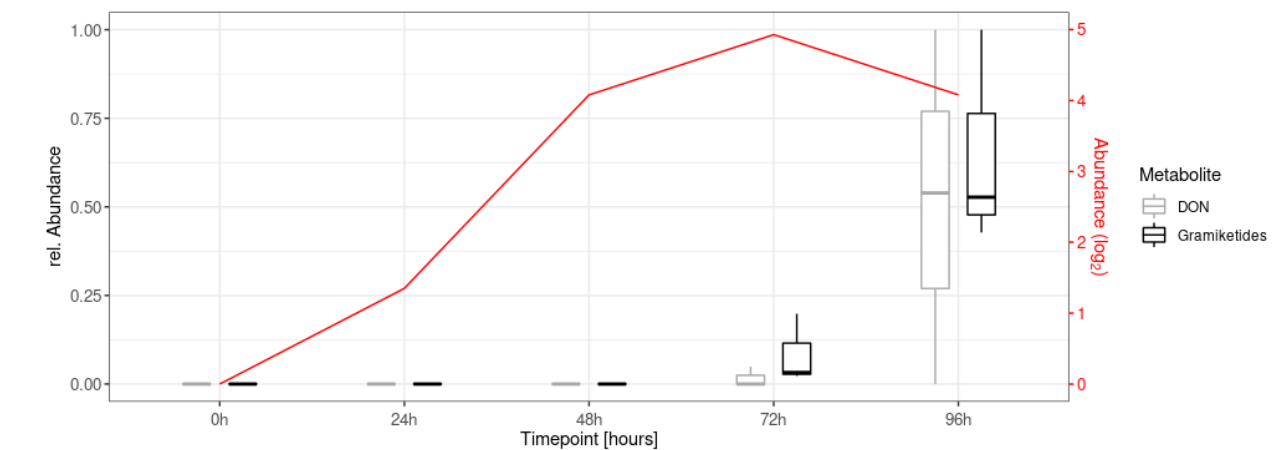
Figure 9. Time course measurement of gramiketide B and deoxynivalenol (DON) abundances from samples taken immediately (0 h) to four days after infection (point inoculation of wheat flowers with F. graminearum PH-1 wild-type at anthesis). Peak areas are normalized relative to the highest value per metabolite. Transcription levels (for experimental details and methods of obtaining transcription data, refer to Schweiger et al. [41]) of the PKS15 gene (FGSG_04588) are shown in red.